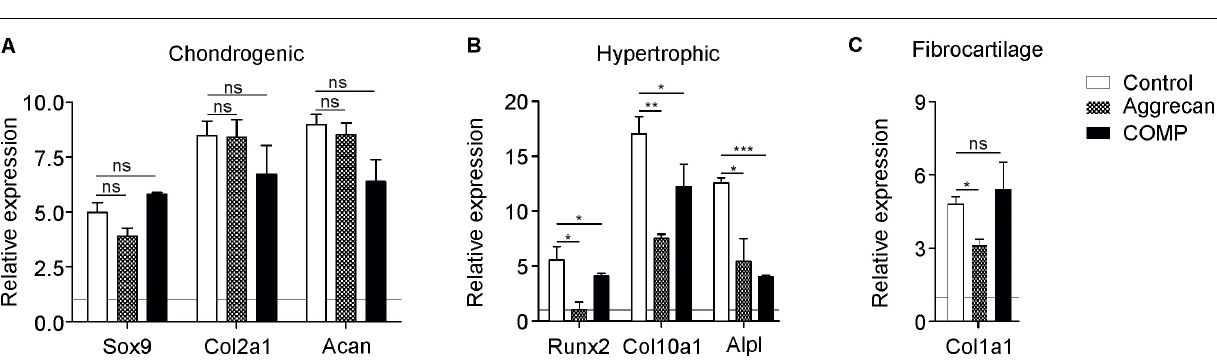
FIGURE 2 | Better cartilage quality of chondrocytes generated from periosteal tissue when exposed to Aggrecan or COMP. Chondrocytic cells derived from ectopic generated cartilage out of periosteum tissue were redifferentiated under control conditions (white bars) and with Aggrecan (2 µ g/ml; dotted bars) or COMP (200 µ g/ml; black bars) for 7 days. (A) Induction of chondrogenic markers Sox9, Col2a1, and Acan mRNA expression was determined by RT-qPCR, normalized for 28S rRNA expression and set relative to baseline ( t = 0) values (indicated by horizontal line). (B) Induction of hypertrophic markers Runx2, Col10a1, and Alpl mRNA expression was determined similarly to samples from (A). (C) Fibrocartilage marker Col1a1 mRNA expression was determined similarly to samples from (A) . In graphs, error bars represent mean ± SEM. Statistically significant differences ( p < 0.05) are shown by an *, ** = p < 0.01, *** = p < 0.0001, ns = not